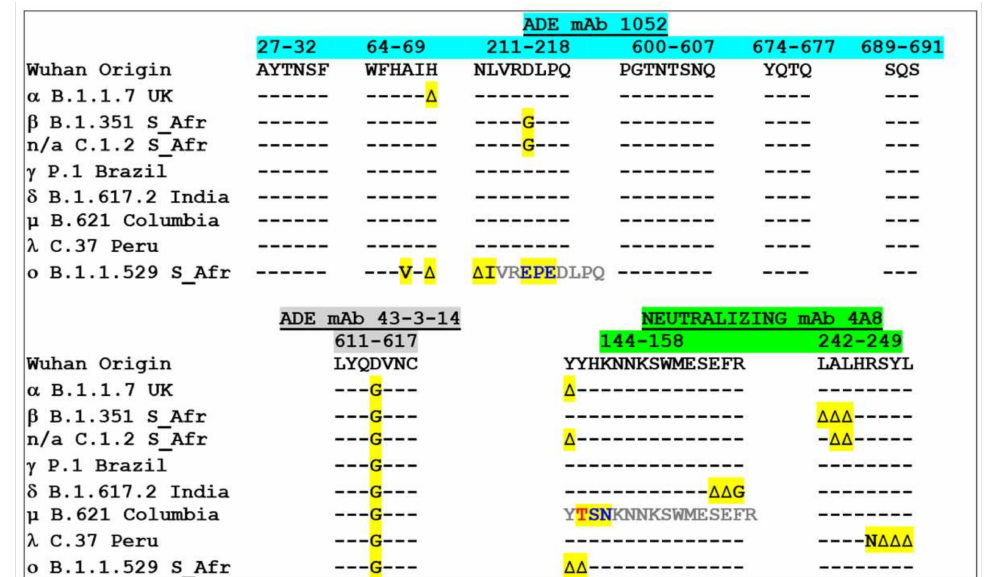
Figure 3. Amino acid sequence alignments of ADE and neutralizing epitopes in SARS-CoV-2 variants. Amino acid residue variations are highlighted in yellow. -, identity; ∆ , deletion. Note that the 144-158 neutralizing epitope of the mu ( µ ) variant displays a threonine residue (T, in red) inserted after Y144, then two mutations after this insertion (colored in blue). The insertion induces a shift of the amino acid sequence (highlighted in